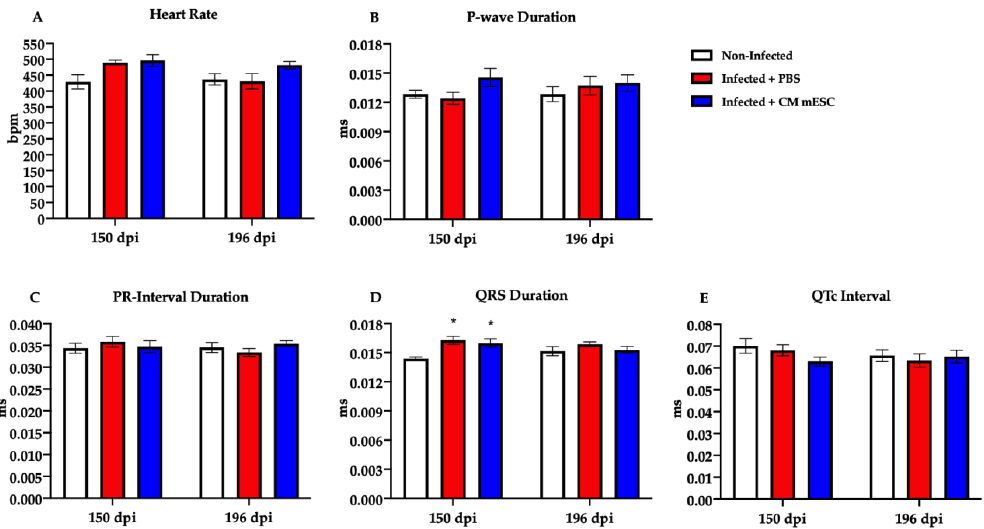
Figure 4. Electrical activity evaluation by electrocardiogram (ECG). Measures were performed 150 and 196 (corresponding to 45 days after the injection of CM-mESC or PBS in infected mice) days post-infection (dpi). ( A – E ) Analysis of heart rate ( A ), PR interval ( B ), P-wave duration ( C ), QRS duration ( D ), and QTc interval ( E ). Two away ANOVA with Tukey’s comparison test: * p < 0.05 compared to the Non-infected group. Data shown as mean ± standard error of mean; n = 13 for Non-infected group, n = 7 for Infected + PBS group, and n = 7 for Infected + CM-mESC group. CM-mESC—cardiomyocytes derived from mouse embryonic stem cells, QTc—corrected QT